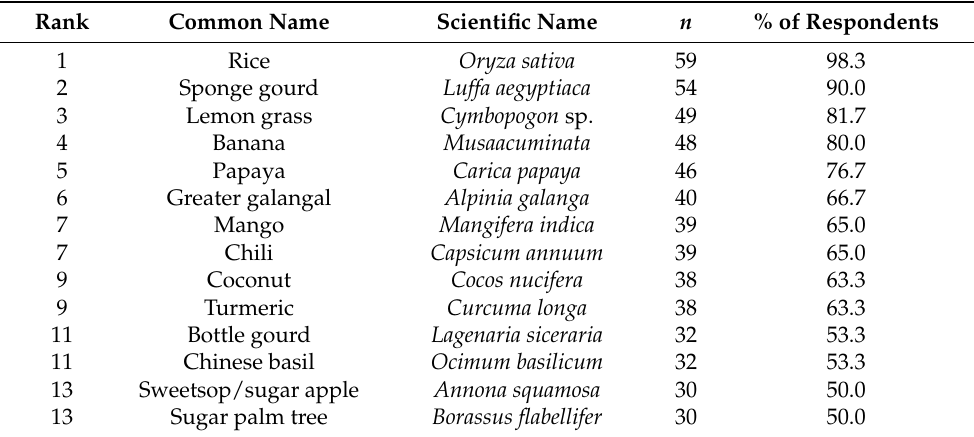
Table 1. Top selected crops by surveyed famers ( n = 60).